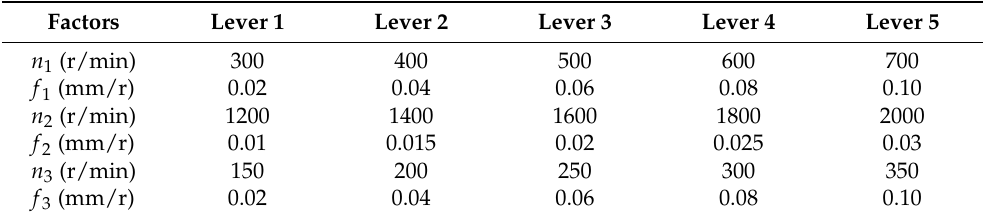
Table 2. Factors and levels of orthogonal experiments.